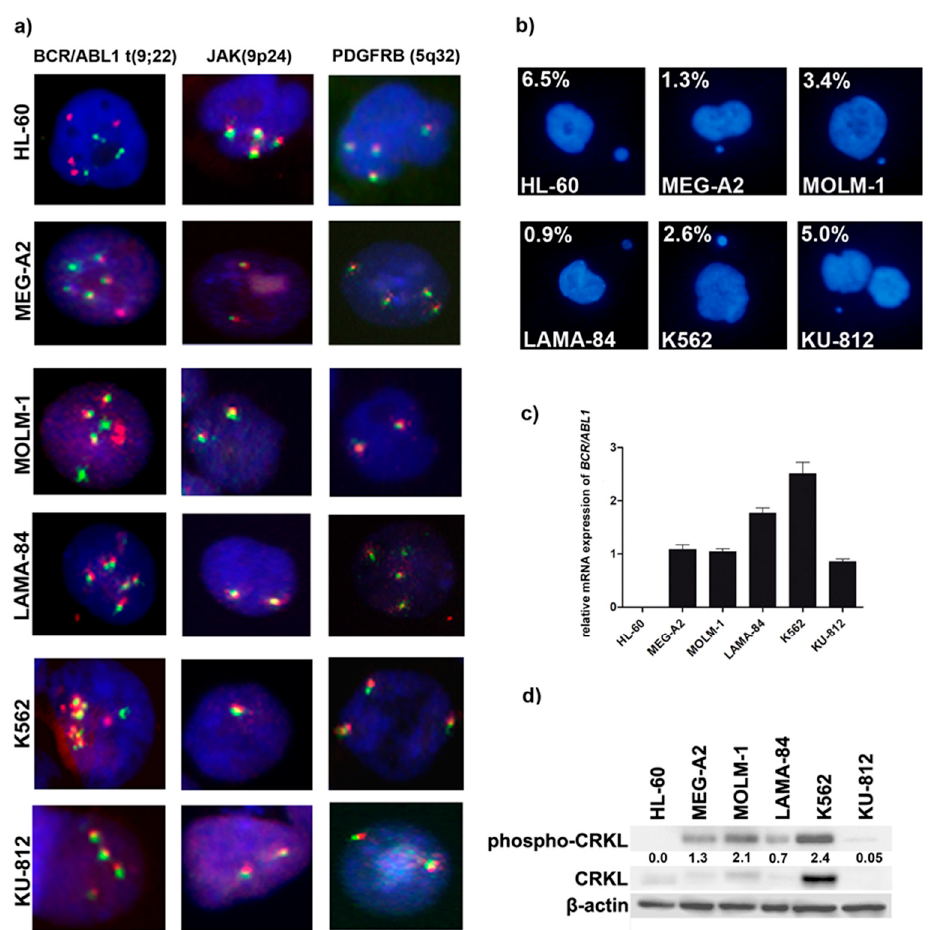
Figure 1. Cytogenetic and molecular features of BCR / ABL1 -positive cell lines. ( a ) Representative images of fluorescence in situ hybridization with BCR-ABL1 t(9;22) fusion probe, JAK2 (9p24) break probe and PDGFRB (5q32) break probe. Fluorescent signals were visualized under the Olympus BX61 and MetaSystem Isis software with objective 40 × ; ( b ) Representative images and percentages of micronuclei (MN) positive cells expressed as %; ( c ) RT-qPCR analysis of BCR / ABL1 normalized to β 2M and GUSB ; ( d ) Assessment of BCR / ABL1 kinase activity, as determined by Western blotting analysis of phospho-CRKL. For the loading control, β -actin was